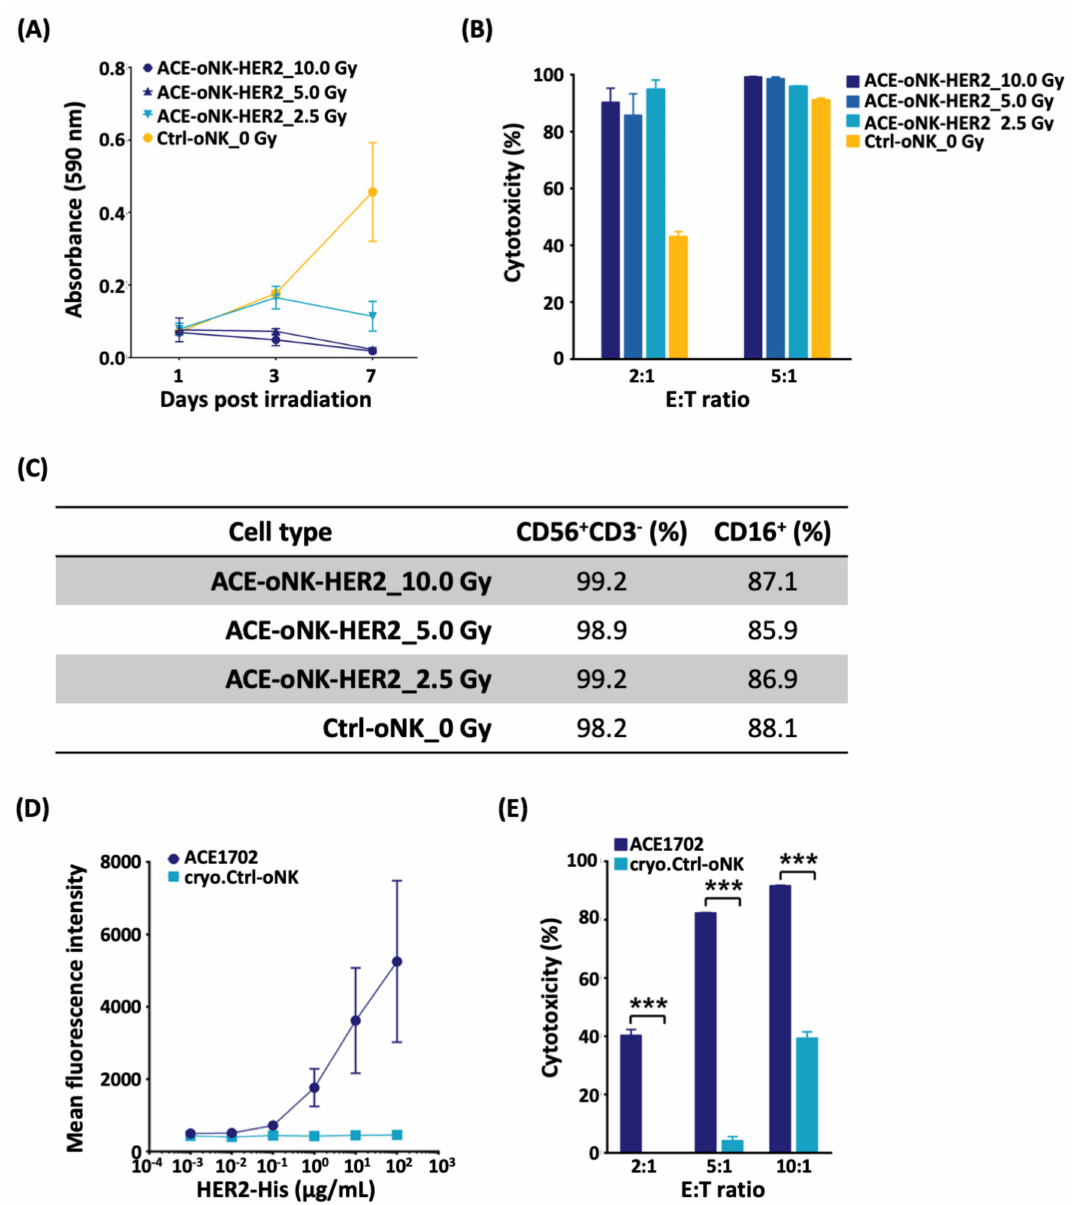
Figure 5. ACE-oNK-HER2 maintains the potency against HER2 + cancer cells after irradiation and cryopreservation. ( A ) The proliferation of ACE-oNK-HER2 irradiated at 2.5, 5.0 and 10.0 Gy as well as non-irradiated Ctrl-oNK cells were analyzed by BrdU incorporation assay. The assay was performed 1, 3 and 7 days post-irradiation. ( B ) Cytotoxicity of irradiated ACE-oNK-HER2 and non-irradiated Ctrl-oNK cells against SK-OV-3 was analyzed at an E:T ratio of 2:1 and 5:1 by the xCELLigence real-time cell analysis system. ( C ) Percentage of CD56 + CD3 - and CD16 + population in ACE-oNK-HER2 irradiated at different doses and non-irradiated Ctrl-oNK cells was analyzed after irradiation on Day 0 by flow cytometry. ( D ) HER2 binding capacity of ACE1702 was examined by incubating with 10 − 3 , 10 − 2 , 10 − 1 , 10 0 , 10 1 and 10 2 µ g/mL of human HER2-His recombinant protein and HER2-bound cells were analyzed by flow cytometry. ( E ) Cytotoxicity of ACE1702 was evaluated by co-incubation with SK-OV-3 cells for 18 h. Three independent experiments were performed and the representative results were shown. Each data point was performed in triplicate. Cytotoxicity was compared between treatments by t test. ***, p <